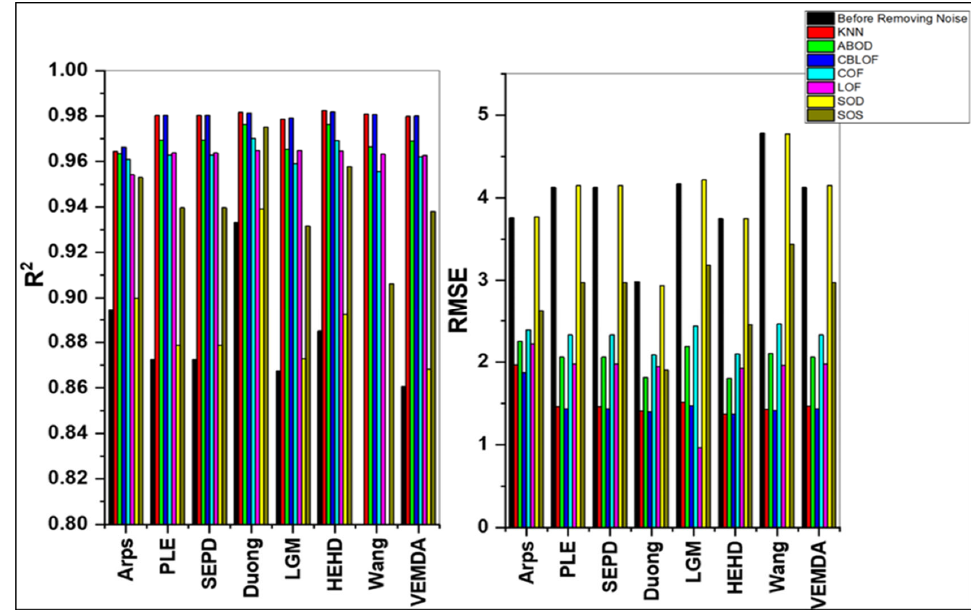
Figure 27. Well_29; R 2 and RMSE after applying eight DCA models before and after removing the noise using the seven algorithms.